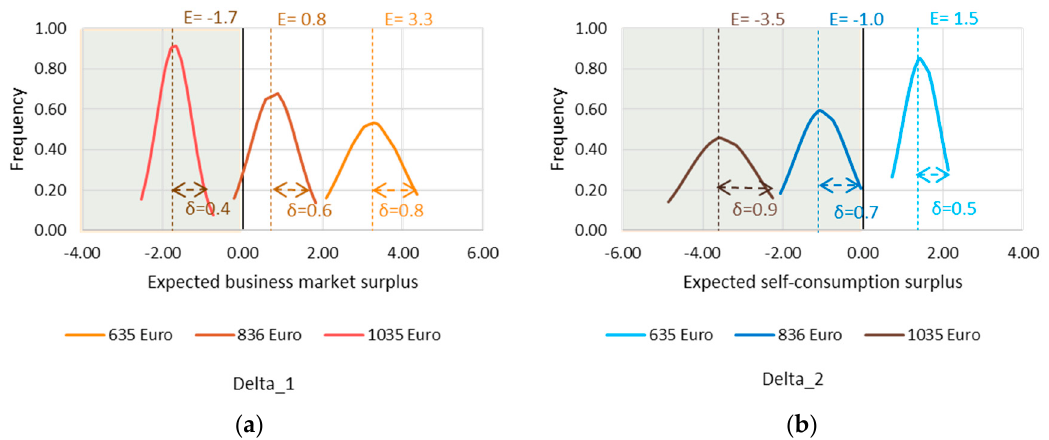
Figure 15. Expected business market ( a ) and expected self-consumption ( b ) surplus change in accordance with investment costs increase from 635 to 1038 Euros/kWp.